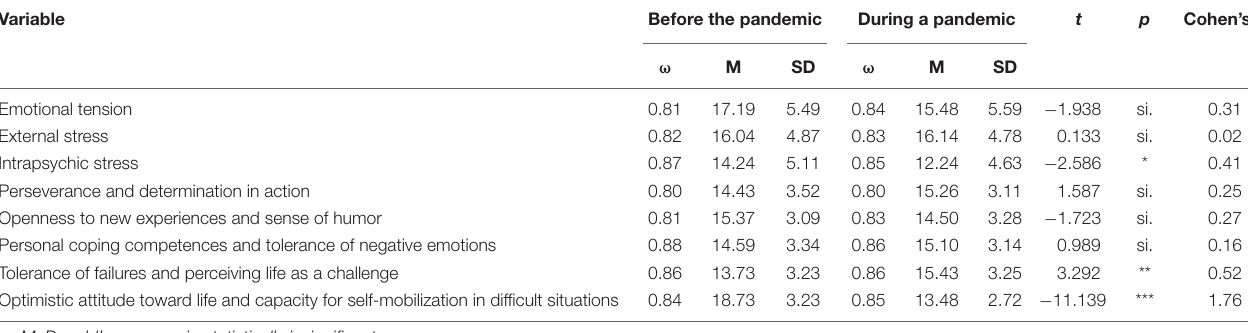
TABLE 1 | Stress and resilience levels among paramedics before and during the COVID-19 pandemic. Variable Before the pandemic During a pandemic